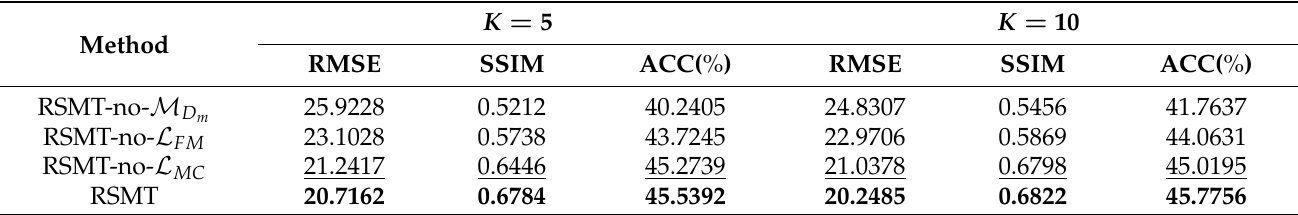
Table 3. Scores of ablation study testing on Los Angeles datasets by removing core elements of RSMT calculated by three evaluation metrics. (bold: best; underline: